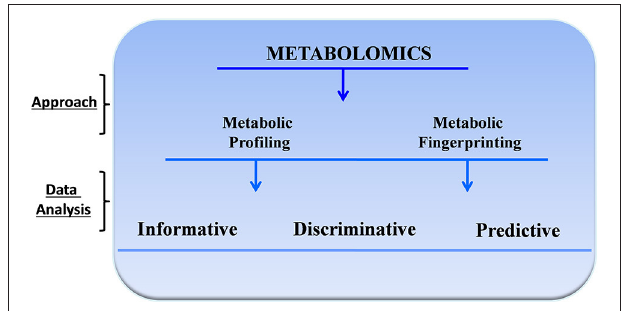
FIGURE 1 | General approach for metabolomics